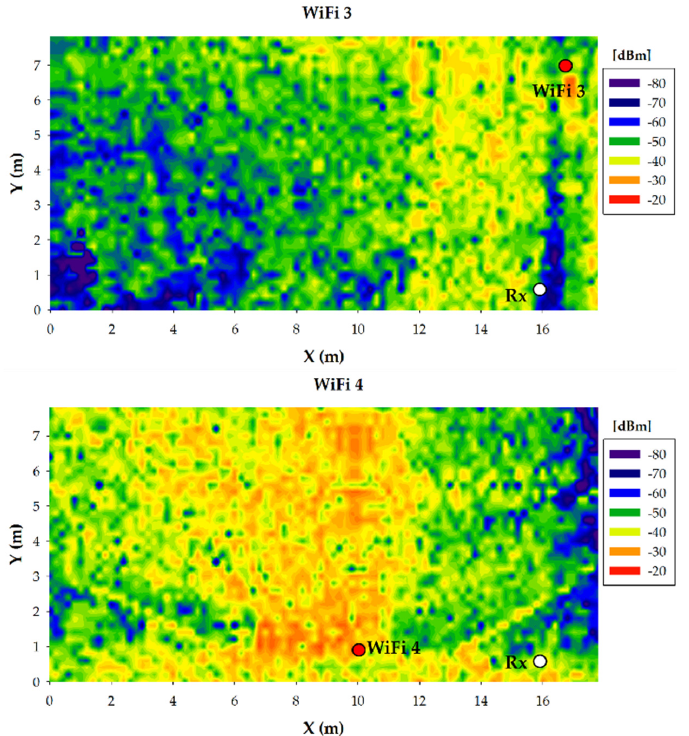
Figure 14. WiFi power distribution for the bidimensional plane at 0.8 m height for the case without persons. The red dots represent the WiFi access point locations.